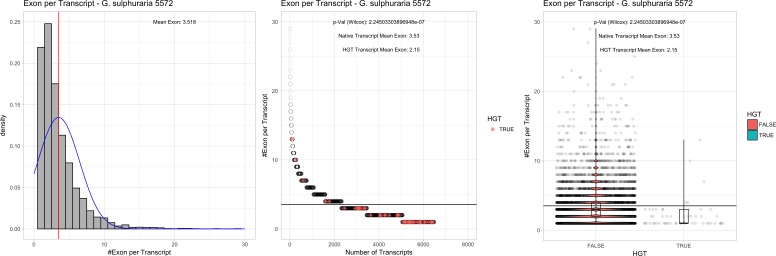
Exon/Intron – Galdieria sulphuraria 5572: (Left) Mid) Cumulative %GC distribution of transcripts.Red line shows the average, blue line a normal distribution based on the average value. The data is categorical (genes have either one, two, three etc. exons) and does not follow a normal distribution. (Mid) Ranking all transcripts based upon their number of exons. Red ‘*' demarks HGT candidates. As the number of exons was not normally distributed, transcripts were ranked by number of exons. In order to resolve the high number of tied ranks (e.g. many transcripts have two exons) a bootstrap was implied by which the rank of transcripts sharing the same number of exons was randomly assigned 1000 times. Wilcoxon-Mann-Whitney-Test applied for the determination of significant rank differences between the native gene and the HGT candidate subset. (Right) Violin plot showing the number of exons per transcript distribution across native transcripts and HGT candidates.